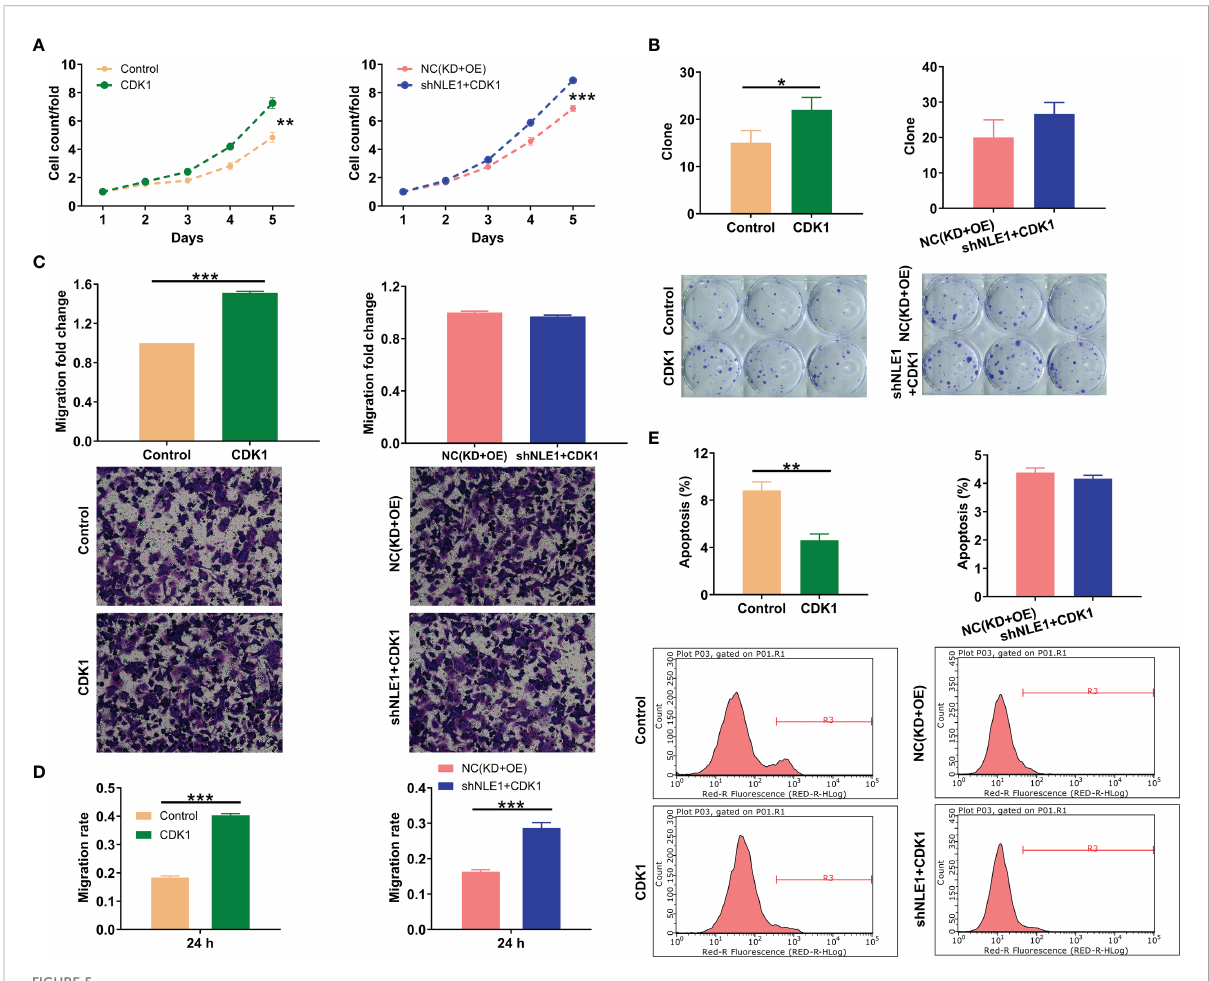
FIGURE 5 CDK1 elevation partially reversed the inhibitory effects of NLE1 knockdown on non − small − cell lung cancer. (A) Celigo cell counting assay was employed to show the effects of alone overexpressing CDK1 as well as simultaneously downregulating NLE1 and overexpressing CDK1 on the cell proliferation of NCI-H1299 cells. (B) Colony formation assay was used to evaluate the abilities of NCI-H1299 cells to form colonies in CDK1 and CDK1+shNLE1 groups. (C, D) The migration abilities of NCI-H1299 cells were detected in CDK1 and CDK1+shNLE1 groups by transwell assay (C) and wound-healing assay (D) . Magni fi cation times: 200×. (E) The cell apoptosis of NCI-H1299 cells was examined by fl ow cytometry after infecting CDK1 and CDK1+shNLE1. Results were presented as mean ± SD (n ≥ 3). ** P < 0.01, *** P < 0.001, *P <